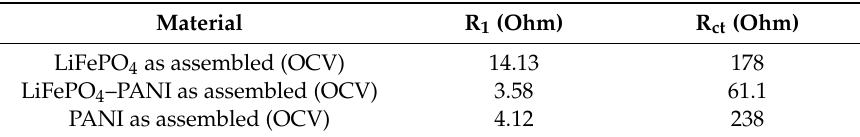
Table 1. Data for impedance spectra at di ff erent cycling stages.